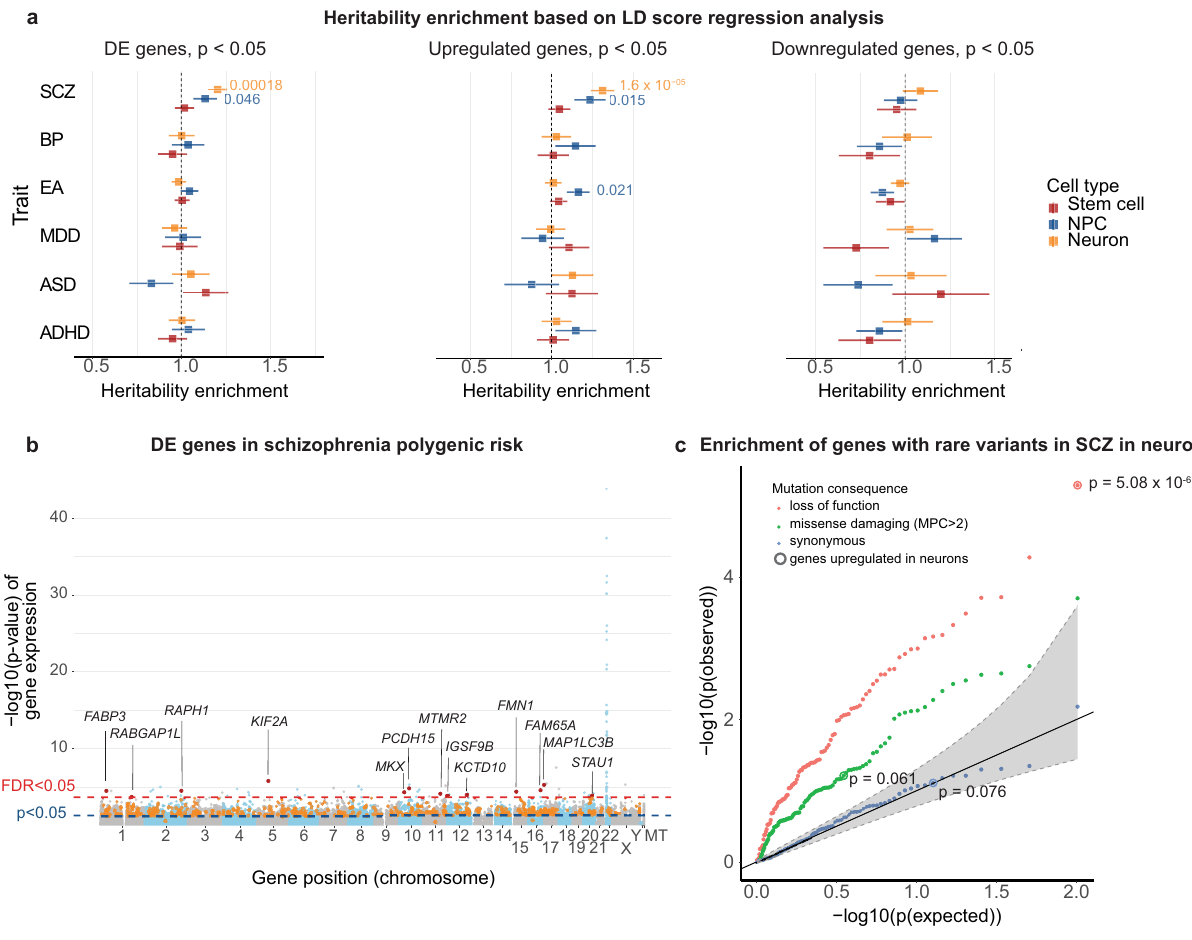
Fig. 3 Heritability enrichment for schizophrenia risk genes 22q11.2 deletion neurons. a Marginal enrichment in Heritability ( + / − SE) explained by common (MAF > 5%) variants within 100 kb of genes differentially expressed, estimated by LD Score regression. Six traits were analyzed: SCZ schizophrenia, BP bipolar disorder, EA educational attainment, MDD major depressive disorder, ASD autism spectrum disorder, ADHD attention de fi cit hyperactivity disorder, at all three cell stages, showing enrichment for schizophrenia most prominently in genes upregulated in 22q11.2 deletion neurons. DE differentially expressed. Three groups of DE genes were analyzed. Left, all nominally signi fi cant DE genes ( p < 0.05, N (DE genes in stem cells) = 2346, N (DE genes in NPCs) = 2076, N (DE genes in neurons) = 3370). Middle, all nominally signi fi cant upregulated DE genes ( p < 0.05, N (genes in stem cells) = 1521, N (genes in NPCs) = 964, N (genes in neurons) = 2173). Right, all nominally signi fi cant downregulated DE genes ( p < 0.05, N (genes in stem cells) = 825, N (genes in NPCs) = 1112, N (genes in neurons) = 1197). The standard errors in LD score regression are derived from block Jackknife that are then used to calculate z scores and P values (two-sided). A signi fi cant heritability enrichment for schizophrenia was found for all DEgenes and upregulated genes in neurons ( p = 0.00018 and p = 1.6 × 10 − 5 , LD score Regression). The test statistic for each comparison is presented in Supplementary Data 6. b DE genes (two-sided Wald-test implemented in DEseq2) in 22q11.2 neurons with nominally signi fi cant gene-wise association to schizophrenia from MAGMA ( p g < 0.05, F-test implemented in MAGMA, two-sided). c qq plot of p-values ( t -test, linear regression, two-sided) with 95% con fi dence interval for the enrichment of rare coding LoF, missense damaging or synonymous variants in schizophrenia patients in genes upregulated in deletion neurons (circled) and 100 random gene sets matched by expression level to the upregulated